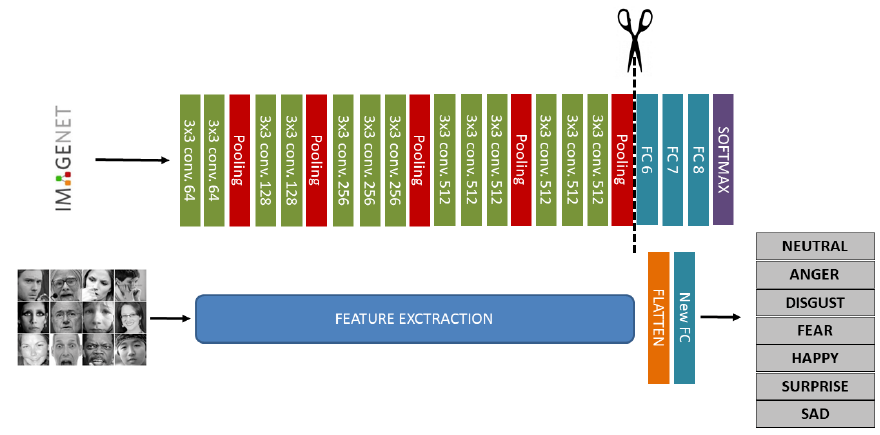
Figure 4. A schematic of the VGG-16 Deep Convolutional Neural Network (DCNN) architecture trained on ImageNet database. The network is 16 layers deep and can classify images into 1000 object categories ( top row ); transfer learning application for FER replacing classification layers of original VGG16 architecture ( bottom row